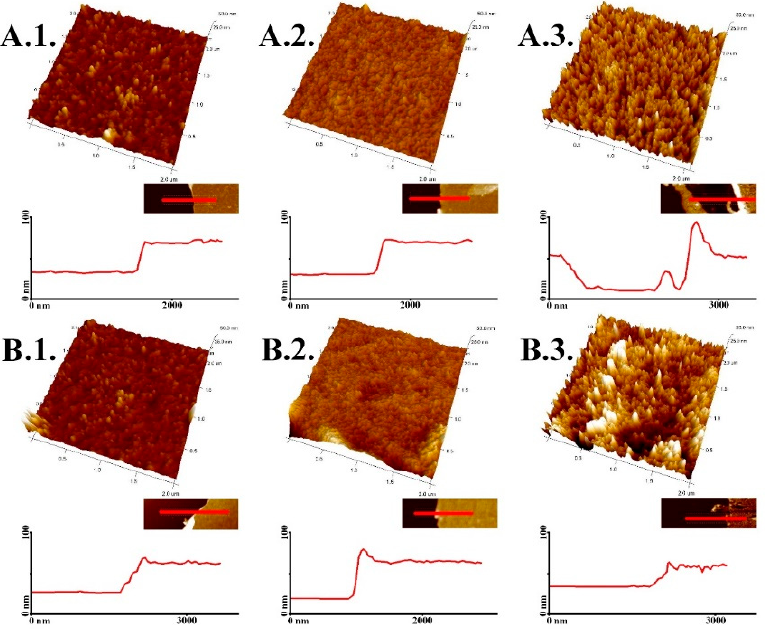
Figure 5. The topography and cross sections of C2H&AAm PEMs on silicon for negatively ( A.1 – A.3 panel) and positively charged topmost layer ( B.1 – B.3 panel) for dry (column 1) and swollen films after 30 min incubation in PBS (column 2) or 1 M NaCl solution (column 3).